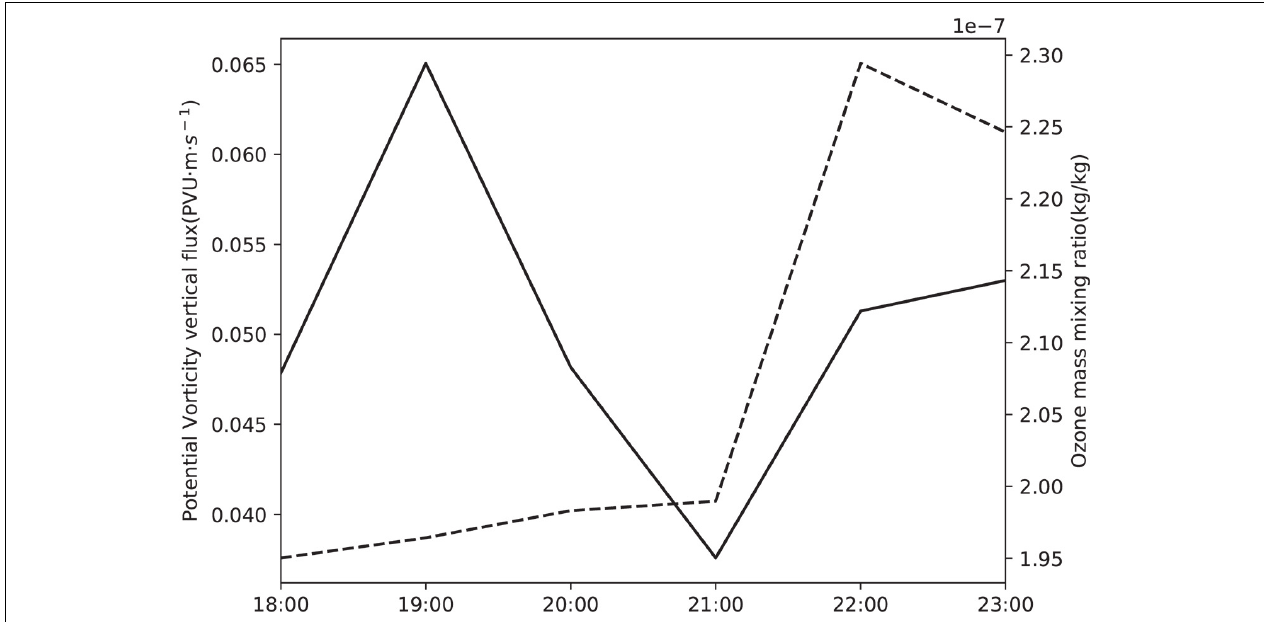
FIGURE 15 | Time variation of the average potential vorticity vertical flux P V (cid:48) w (cid:48) (averaged over the 250–125 hPa, 92.5 ◦ E–98.5 ◦ E area) simulated by WRF (solid line) and the average ozone mixing ratio from ERA5 reanalysis data (dashed line) from 18:00 on 3 May, 2014 to 00:00 on 4 May,